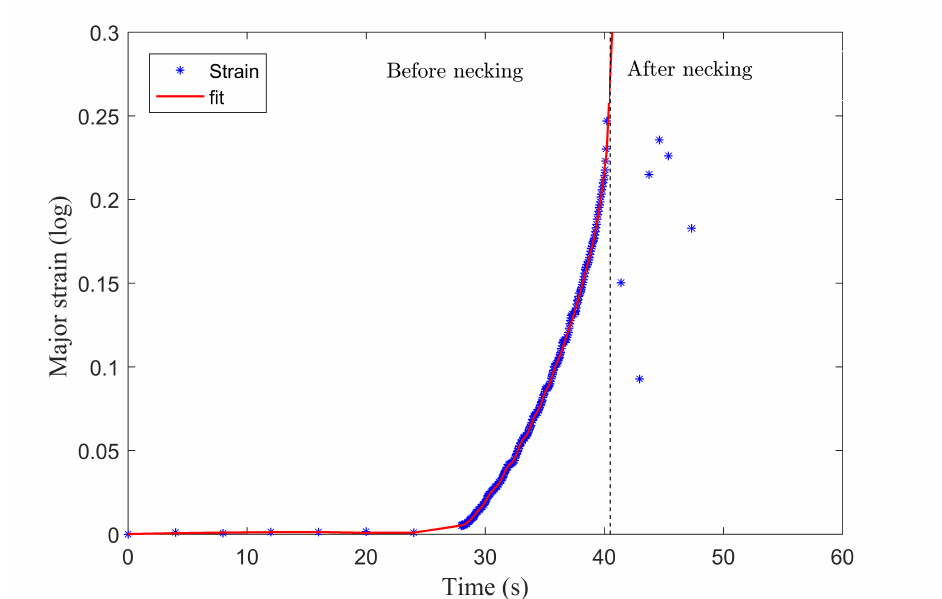
Figure 8. Determination of onset of localized necking for the circular sample (65 mm) of pure Cu: Evolution of the major strain as a function of time.